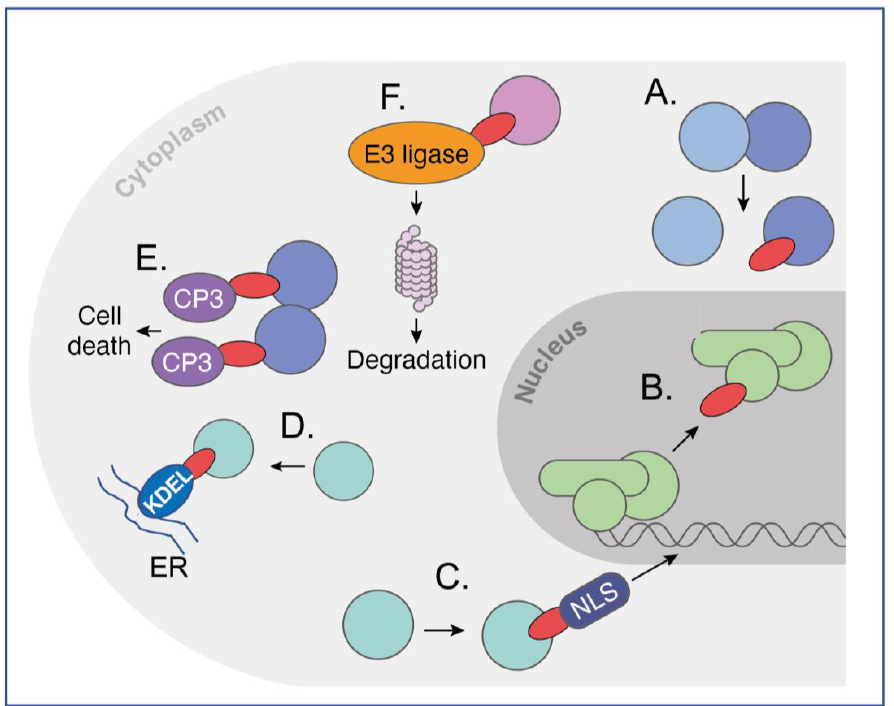
Figure 2. Versatility of intracellular antibodies invoking cellular pathways. Intracellular antibodies can be used in many formats, from whole immunoglobulin to scFv to single variable regions do- mains. The figure depicts several potential functions of intracellular antibodies. The diagram shows several, nonexclusive, independent uses of iDAbs (shown here as ) inside cells that have different functionalities, ranging from iDAb protein ( A , B ) to those fused to effector moieties (warheads) that invoke a cellular property for the effectiveness of the iDAb ( C – F ). In A : an iDAb acts as an inhibitor of a protein–protein interaction; in B : an iDAb acts as an inhibitor of a